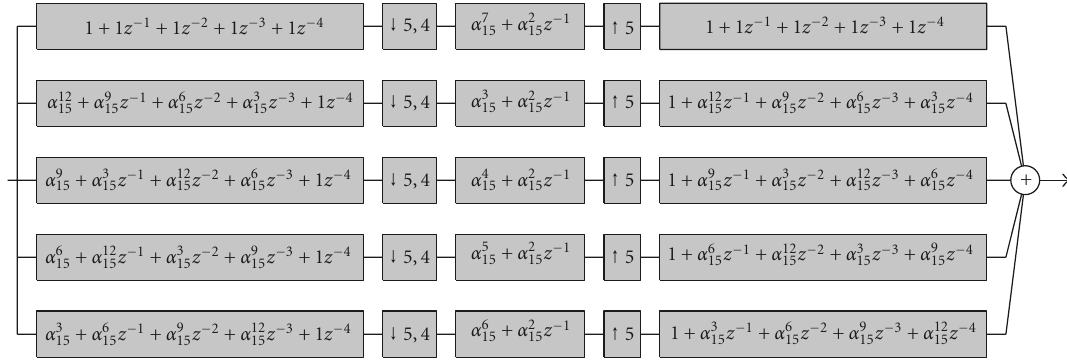
Figure 4: Filter bank with component codes in each subband for the R [15,10] (Example 3).